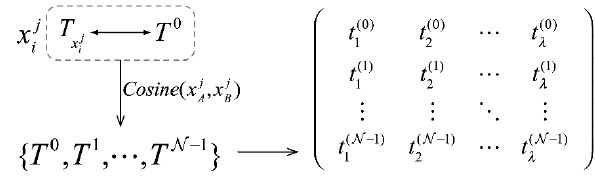
Figure 4. Node sequence pre-processing.